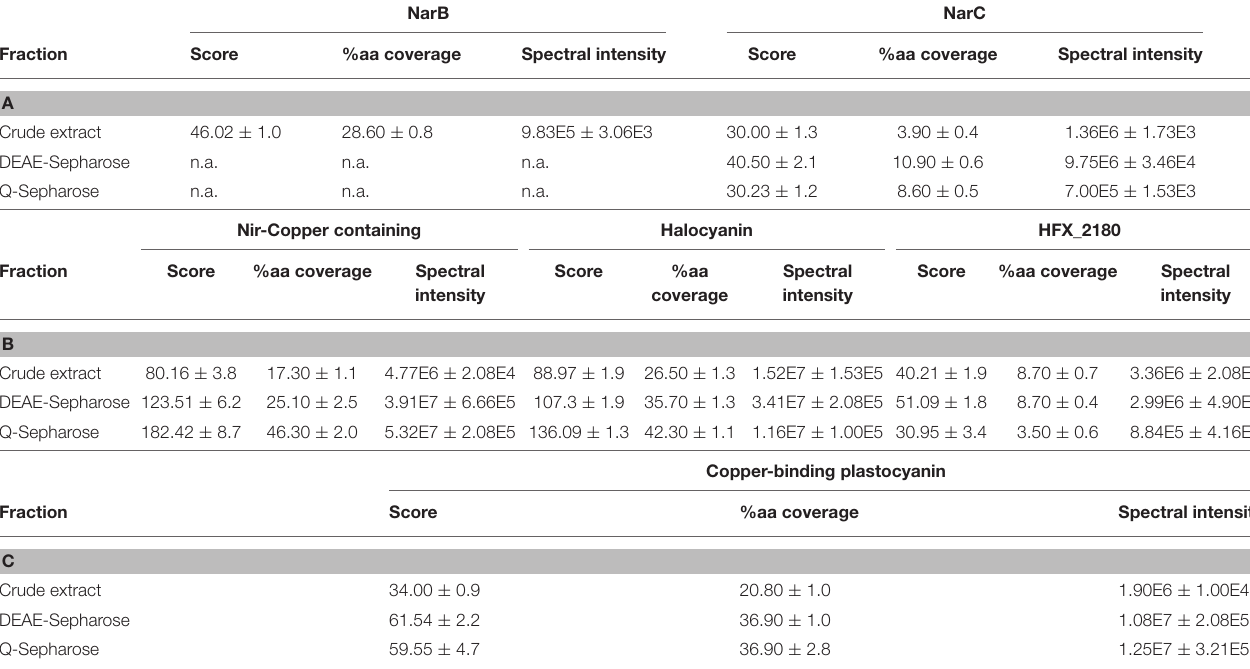
TABLE 4 | Score, percentage coverage, and spectral intensity values of different accessory proteins of denitrification enzymes during the enrichment